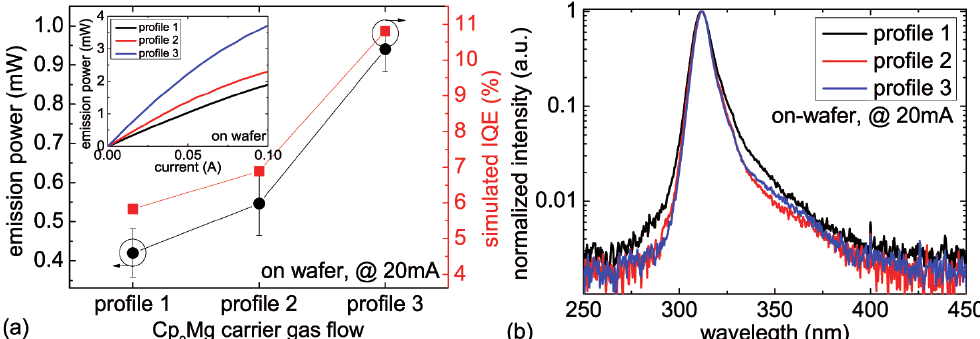
Figure 2. ( a ) measured average emission power (at 20 mA, on-wafer) as well as simulated internal quantum efficiency (IQE) and ( b ) typical normalized emission spectra (at 20 mA, on-wafer) of 310 nm LEDs with different temporal Cp 2 Mg carrier gas flow profiles in the EBL. Inset in ( a ): typical emission power vs. current characteristics of 310 nm LEDs with different temporal Cp 2 Mg carrier gas flow profiles of the EBL.